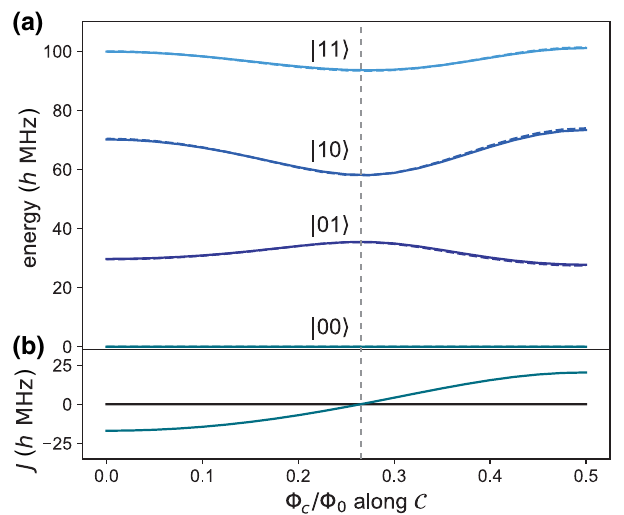
FIG. 5. (a) The low-energy spectrum of the coupled system. As the coupler flux is tuned, the qubit fluxes are adjusted to remain on the sweet-spot contour C , ensuring that (cid:11) μ = 0. The full lines correspond to the exact spectrum calculated from the full-model H , while the dashed lines correspond to the spectrum as calculated from the effective Hamiltonian H eff . The eigenener- gies are labeled according to the bare state | ij (cid:5) ≡ | i a , j b , 0 − , 0 + (cid:5) , with the largest overlap with the corresponding dressed state when the coupler is in the off state (at φ c ≈ 0.27 × 2 π , marked by the gray dashed line). (b) The strength J of the effective XX coupling. The device parameters can be found in Table